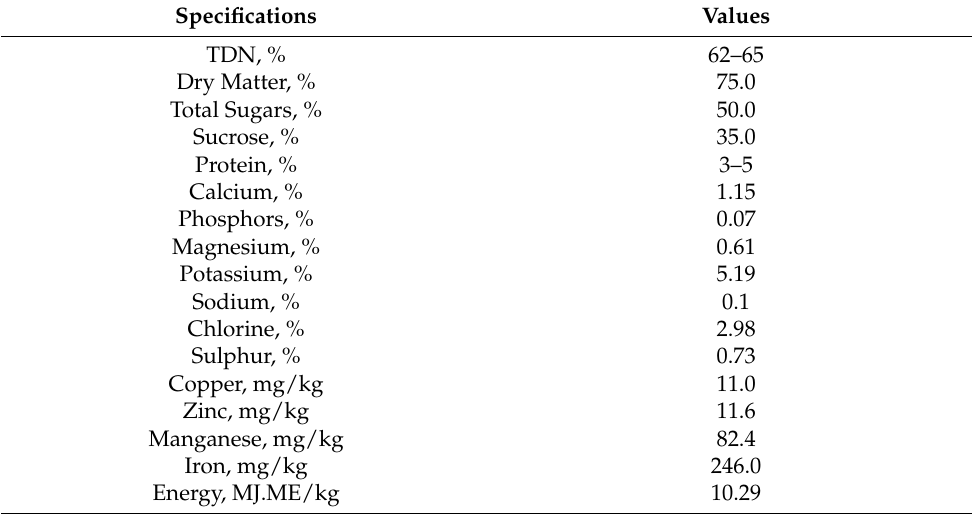
Table 4. Bundaberg molasses analysis